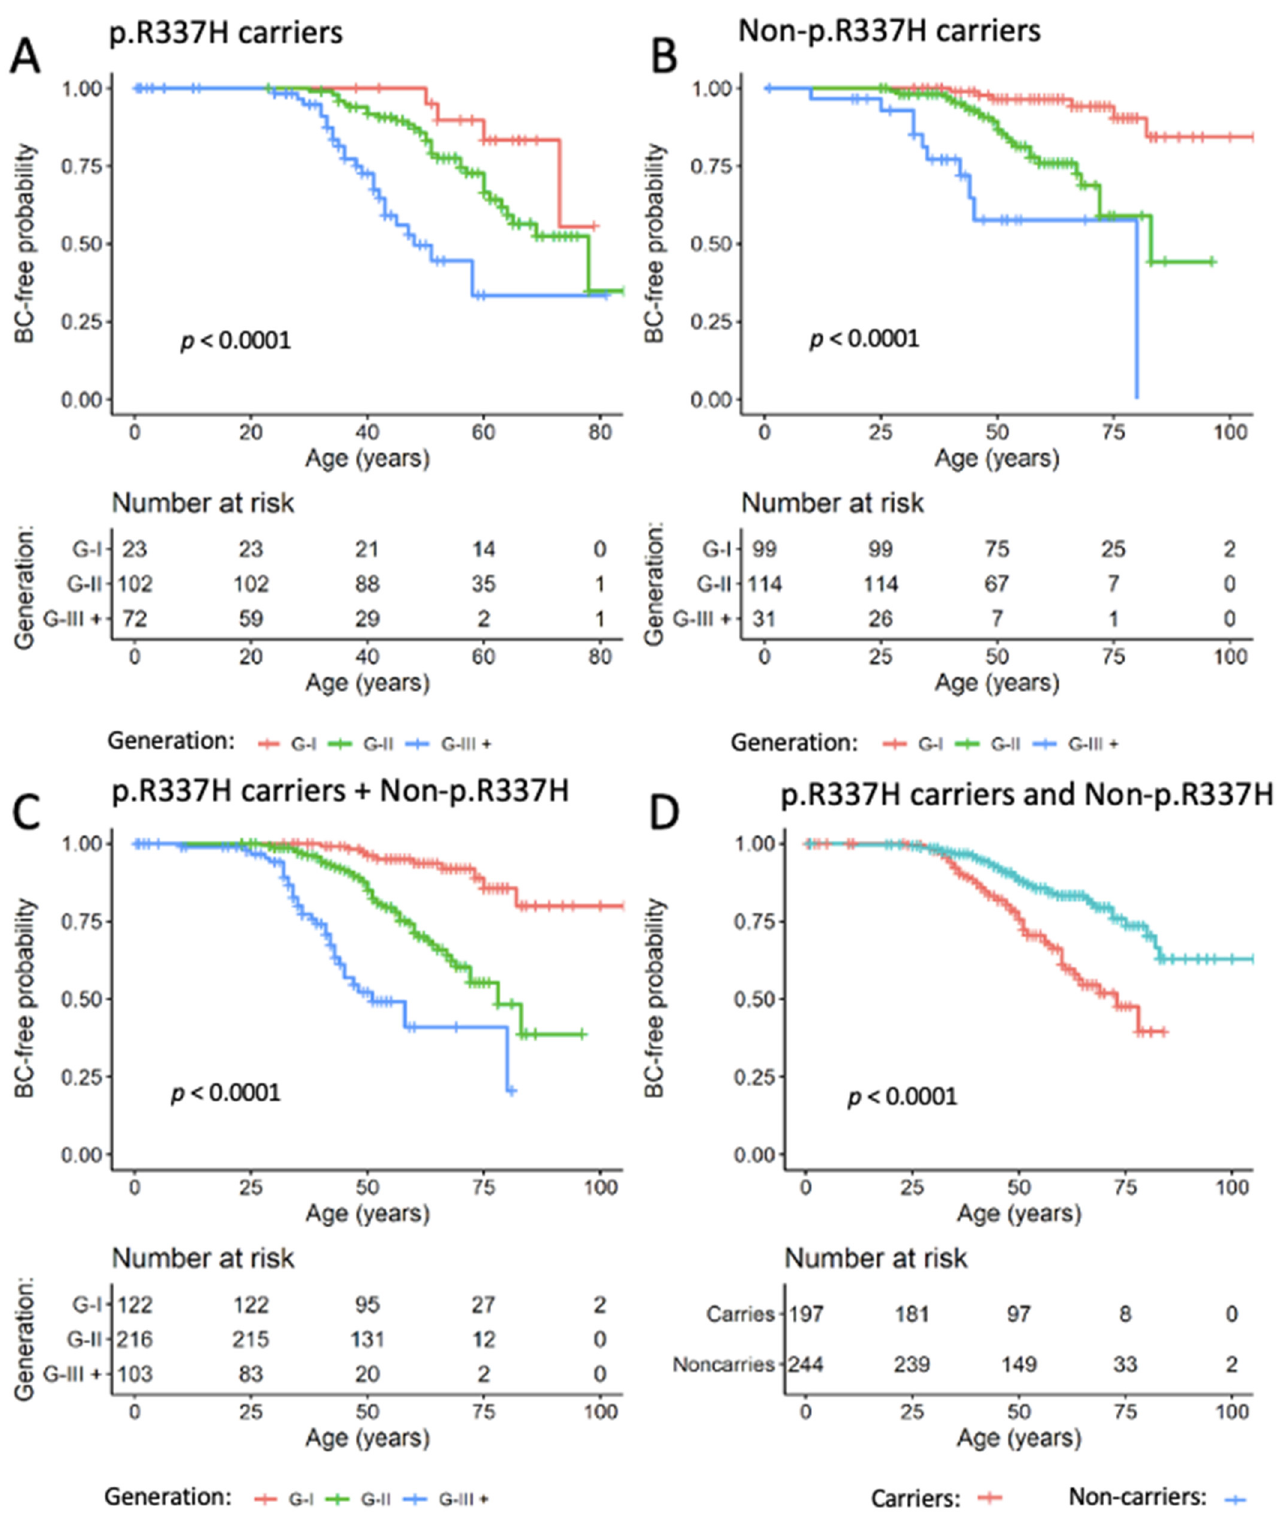
Figure 1. BC-free probabilities among TP53 p.R337H carriers and noncarriers (Group 1). Censoring (vertical line) is indicated by vertical marks. BC occurrences in three generations (last two or three were grouped as the third generation) are shown in panels ( A – C ). Panel ( D ) (grouping all generations) shows younger age of BC among p.R337H carriers than noncarriers.